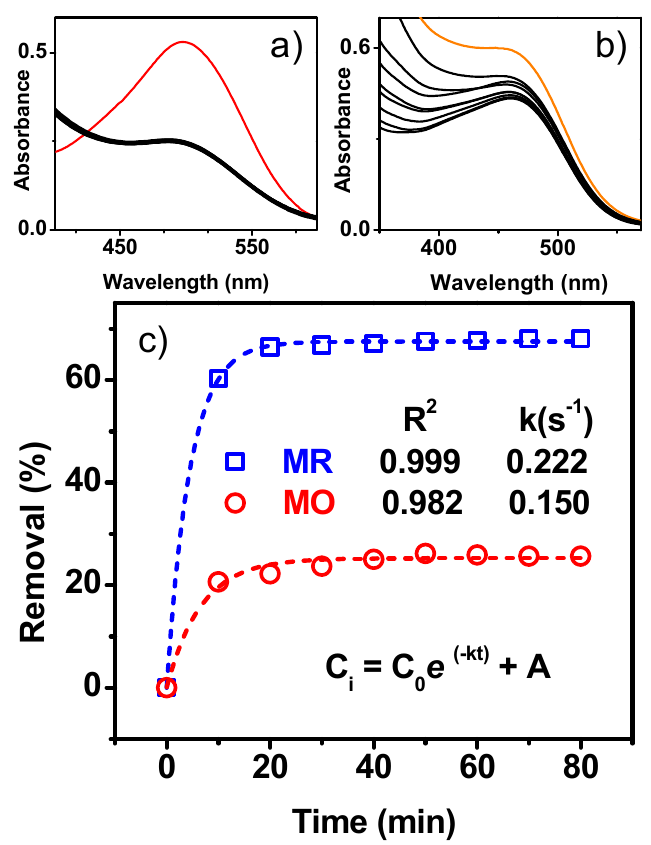
Figure 11. Organic dye removal using the CT- Sargassum spp. filter: ( a ) UV-Vis spectra of methyl red (MR), ( b ) UV-Vis spectra of methyl orange (MO). The spectra were recorded every 10 min. ( c ) Removal curves for methyl red and methyl orange.